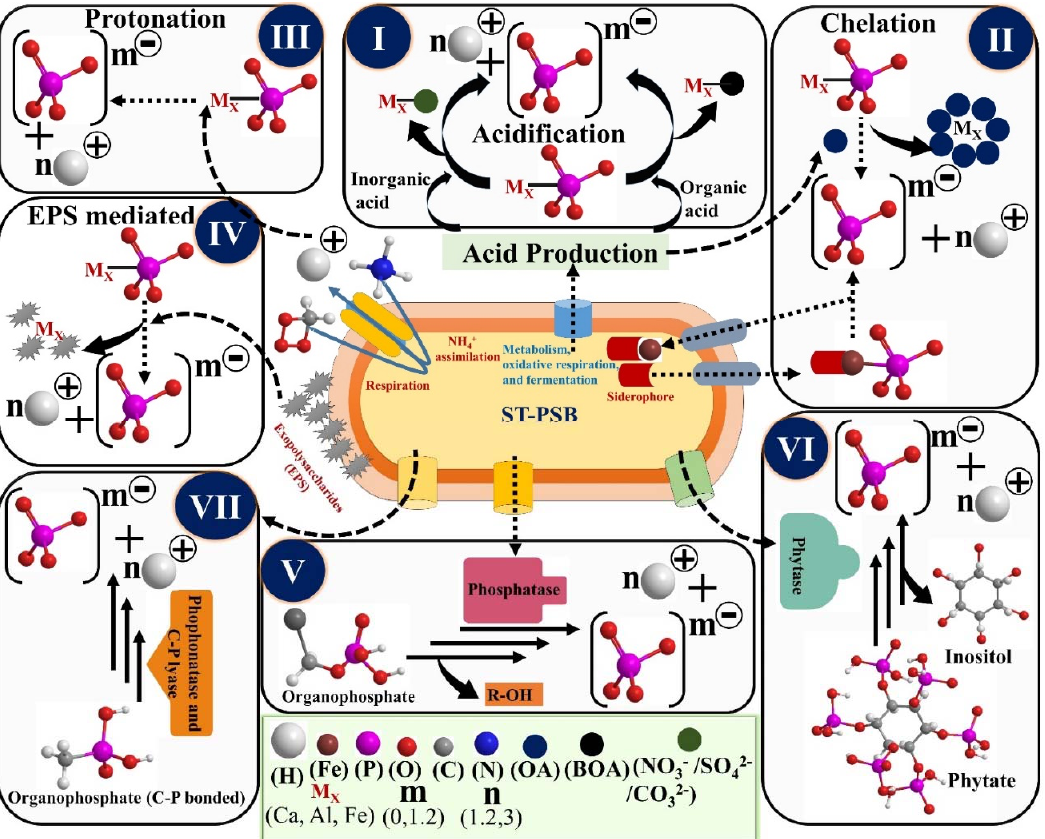
Figure 2. Salt tolerant phosphate solubilizing bacteria mediated P transformation mechanism followed via inorganic phosphate (Pi) solubilization (I, II, III, and IV) and organic phosphate (Po) mineralization (V, VI, and VII). Abbreviation, OA: organic acid; BOA: base of an organic acid; NO 3 : nitrate; SO 42 ‐ : sulphate; CO 32 ‐ : Carbonate ion.